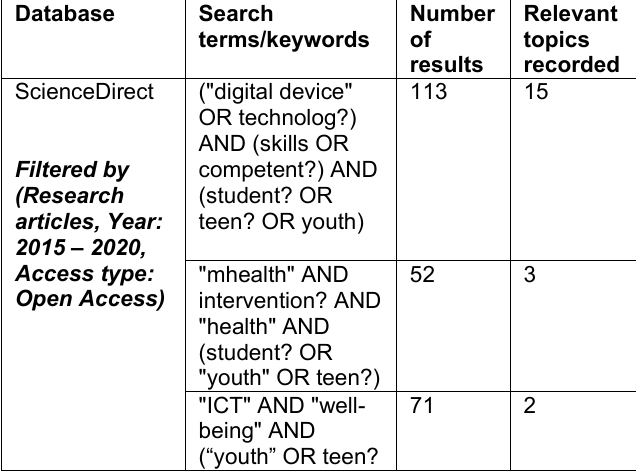
Table 5. Search method to find relevant topic